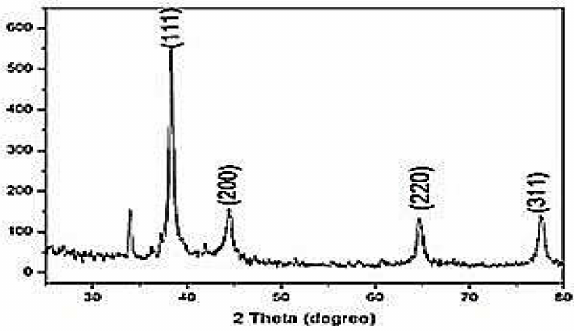
Figure 4. XRD spectrum of AgNPs synthesized from Allium sativum (garlic).